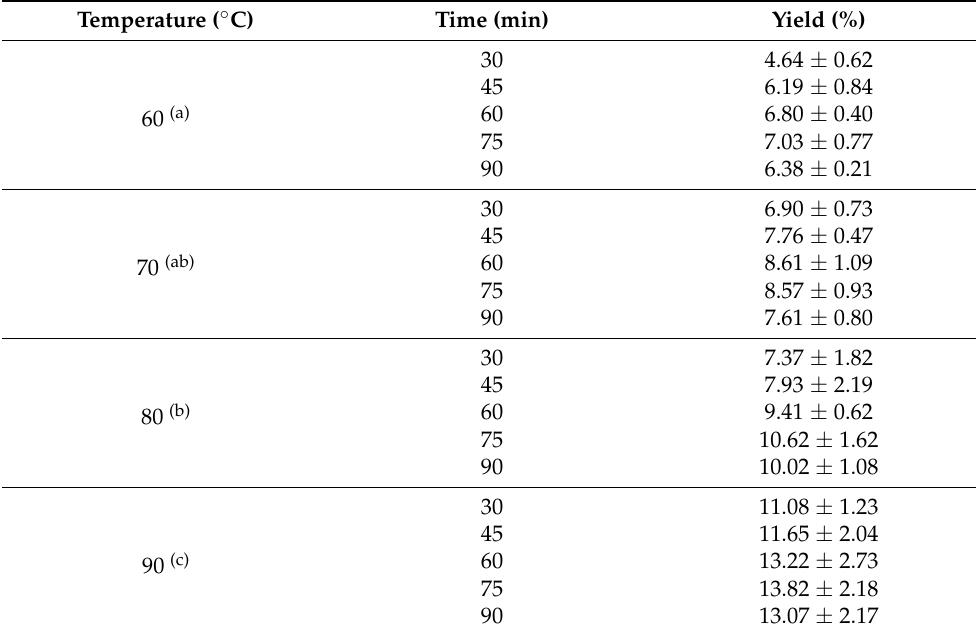
Table 2. Haden mango peel pectin extraction yields at the different evaluated